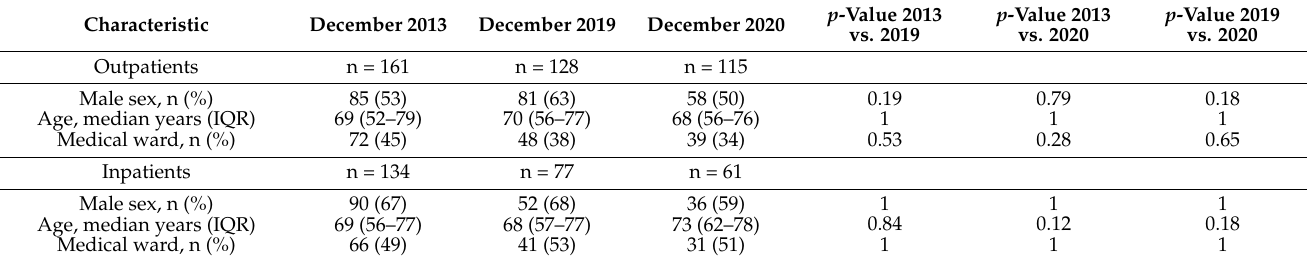
Table 1. Demographic characteristics of patients who received oral quinolone prescriptions.